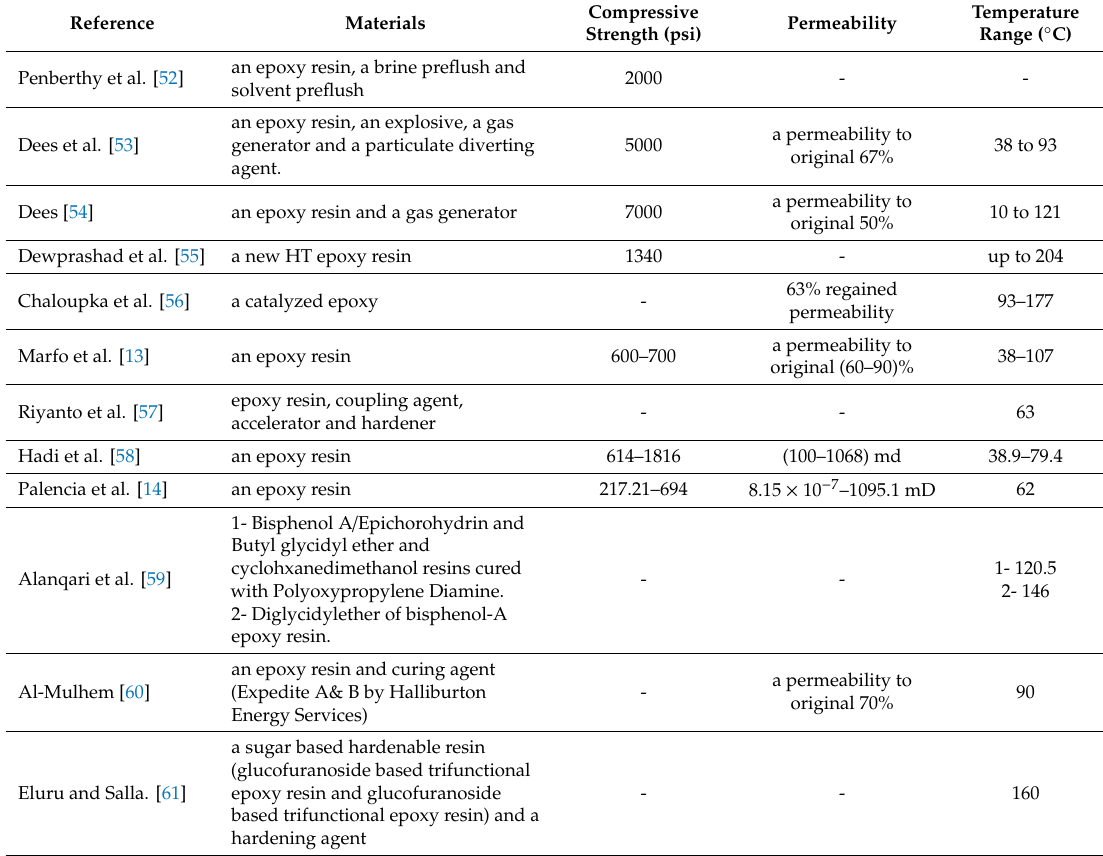
Table 5. Epoxy resin methods to consolidate sand formation.